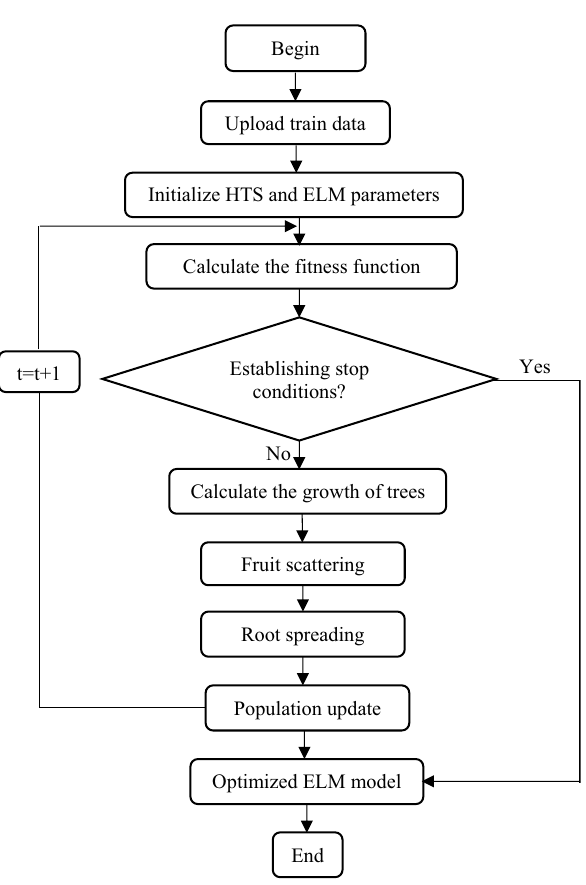
Fig. 5 Flowchart of the HTS–ELM model Table 4 Mean values of irrigation parameters section